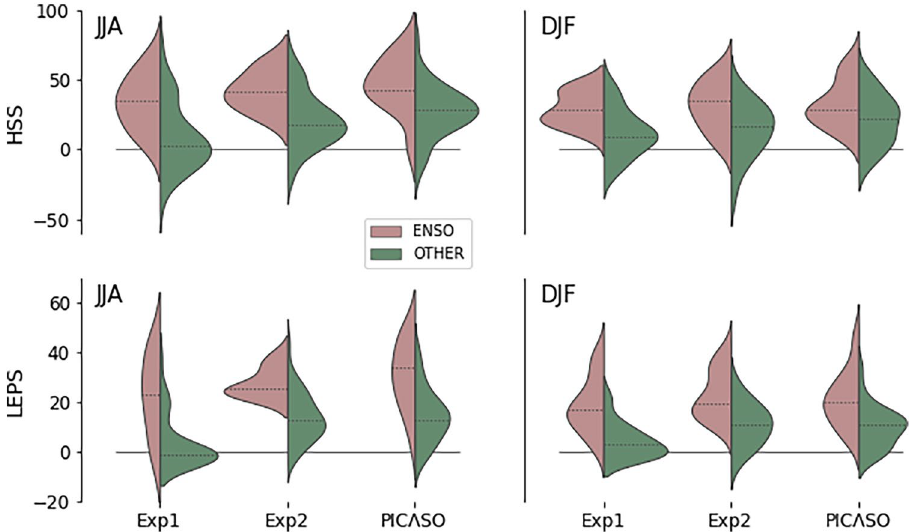
Figure 1. Heidke Skill Scores (HSS; upper) and LEPS scores (lower) for JJA (left) and DJF (right) seasons for the three experiments: (Exp.1) canonical predictor, relationship-based: All predictors are replaced by the model-predicted Niño3.4 index. (Exp.2) optimal predictor, spread-based: The mapping is replaced by a simple linear regression with the predicted variance estimated from the inter-model spread of predictors; and (PICASO) optimal predictor, relationship-based: Both hand-picked optimal predictors and relationship-based Bayesian regression are applied, which are the same methodologies utilized in PICASO. The left and right sides of each violin plot are the distribution of scores for the stations with dominantly impacted by ENSO (denoted as ‘ENSO’; rosy brown), and the stations where other remote forcing dominates or large-scale forcing is obscure (denoted as ‘OTHER’; green),